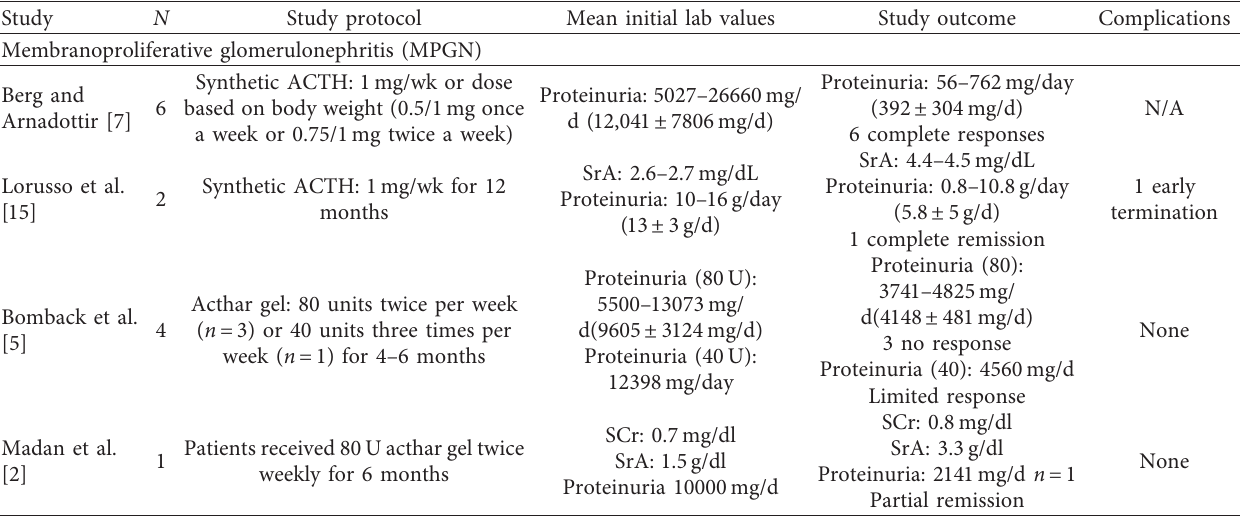
Table 10: Summary of studies on ACTH in membranoproliferative